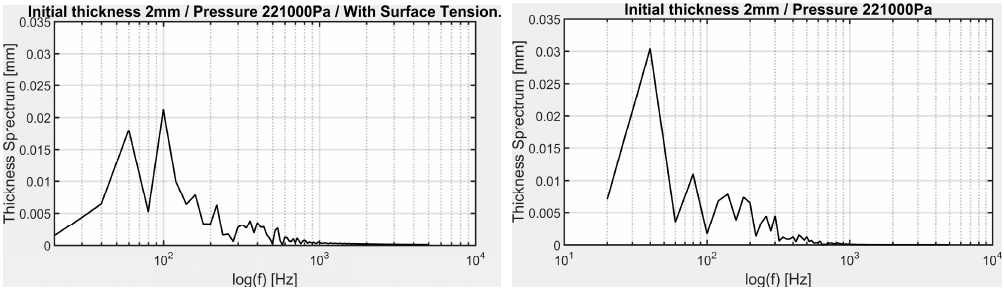
Figure 6. Thickness spectrum (( Left ) with surface tension, ( Right ) without